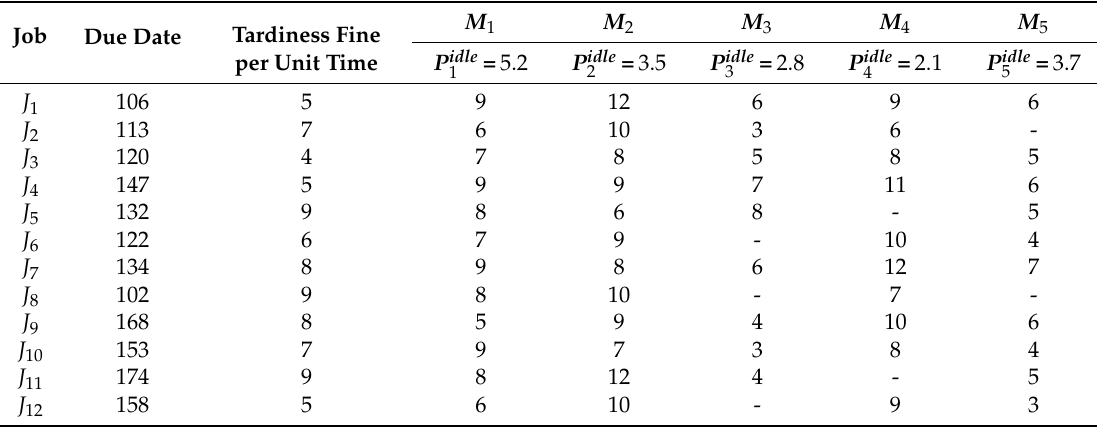
Table 3. The basic data in case 3 (12 jobs × 5 machines).